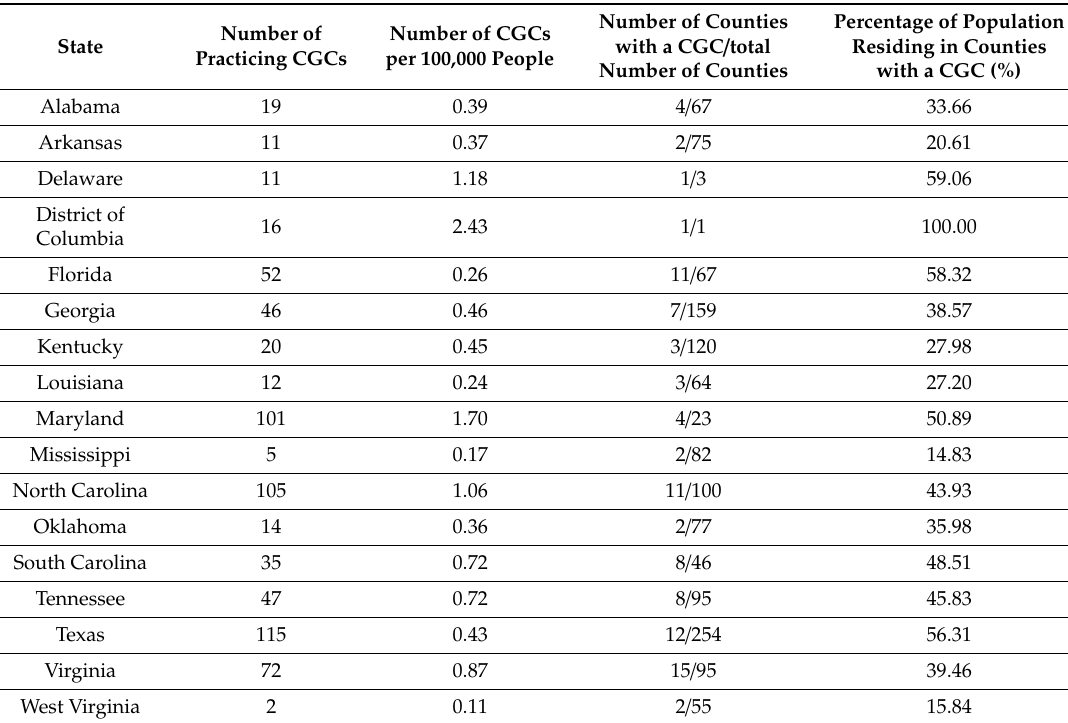
Figure 1. The distribution of certified genetic counselor's workplace in the 17 states of the South. Table 1. The number of practicing certified genetic counselors (CGC) per state in the Southern United States. Source: Population Data—American Community Survey